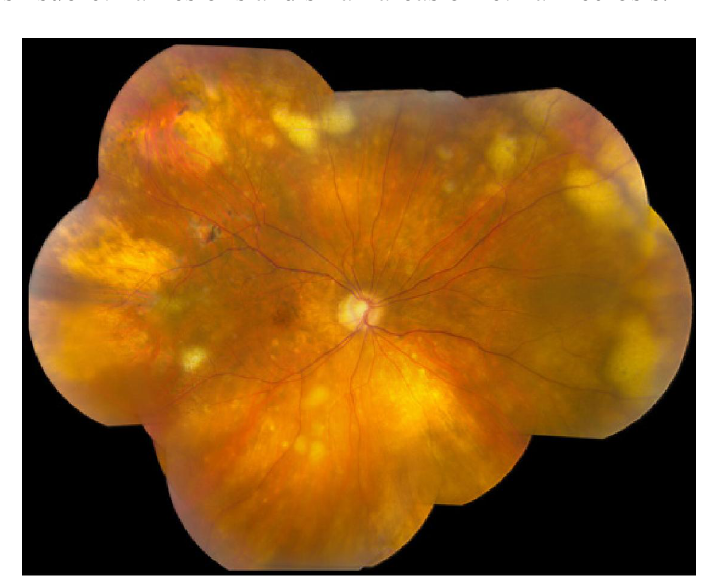
Figure 1. Fundoscopy of a patient with primary vitreoretinal lymphoma (PVRL) showing multiple yellowish subretinal lesions and small areas of retinal